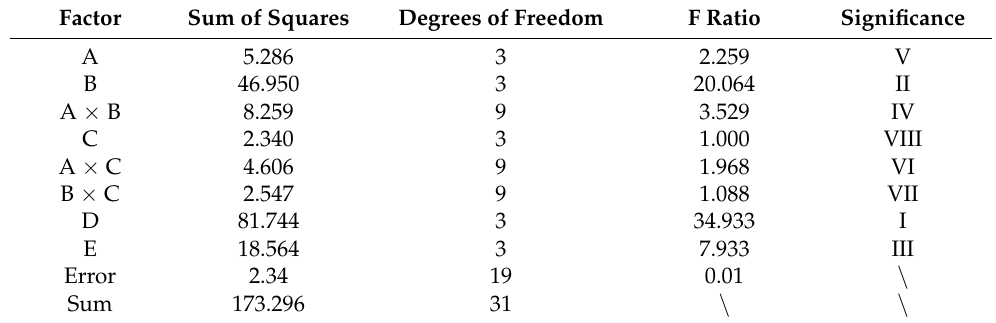
Table 8. Significance test of factors affecting the peak intensity σ 1 when the interaction was